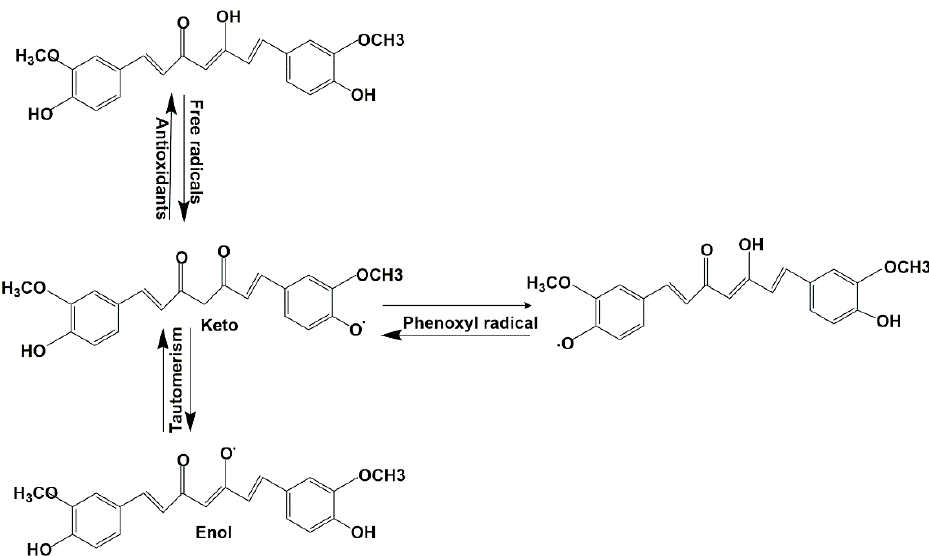
Figure 1. Structure and antioxidant mechanism of curcumin. The structures were drawn using CD Chemdraw v 15.1.0.144 (PerkinElmer, Waltham, MA, USA).